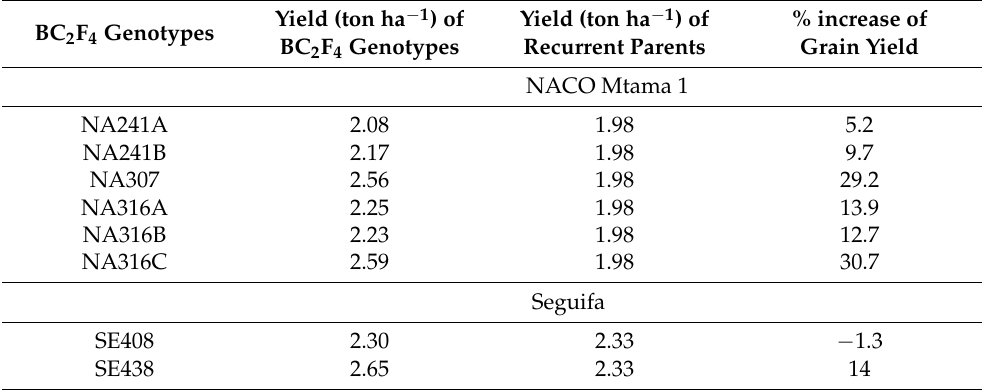
Table 3. Percentage yield increases of BC 2 F 4 genotypes versus recurrent parents under water- stress